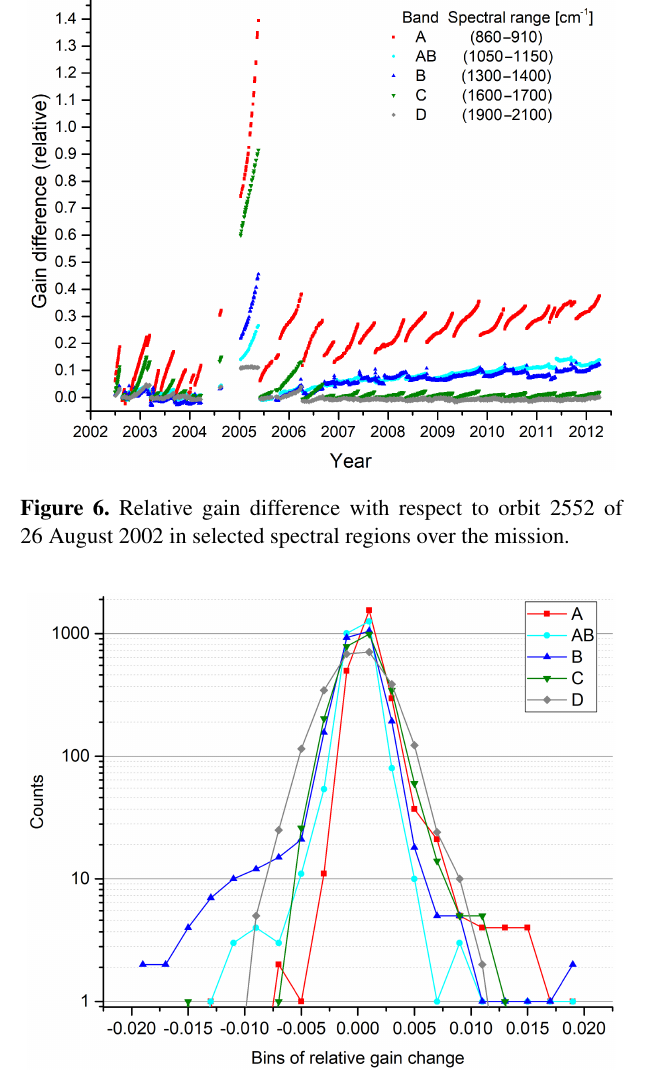
Figure 7. Histogram of the relative gain change in the five spectral bands over the